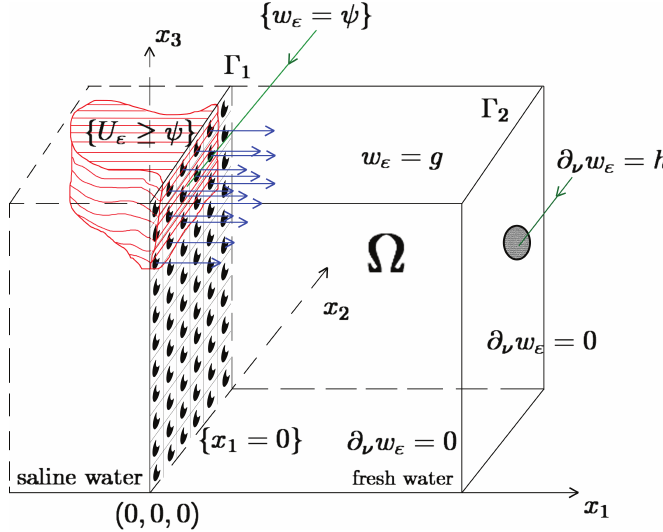
Figure 1: A simple illustration of a plant with a reverse osmosis